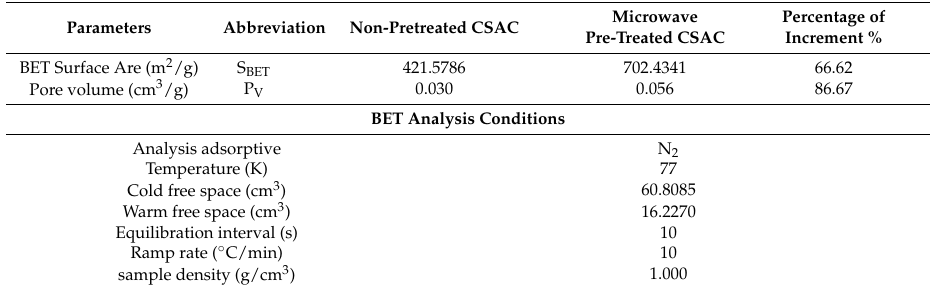
Table 3. Summary of the BET analysis for both microwave pretreated and non-pretreated CS-AC.